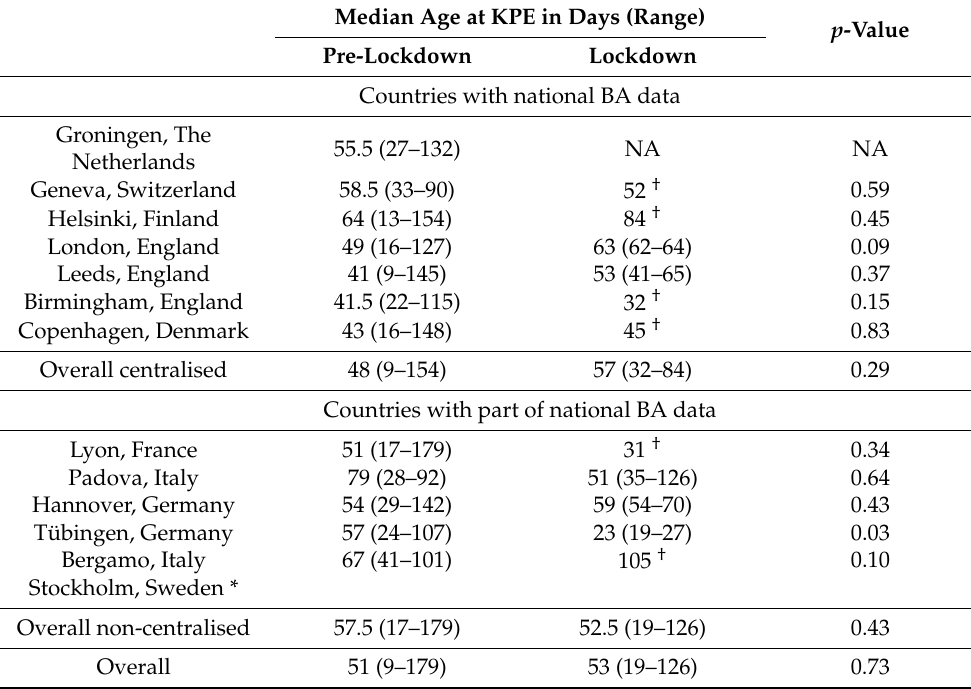
Median Age at KPE in Days (Range)